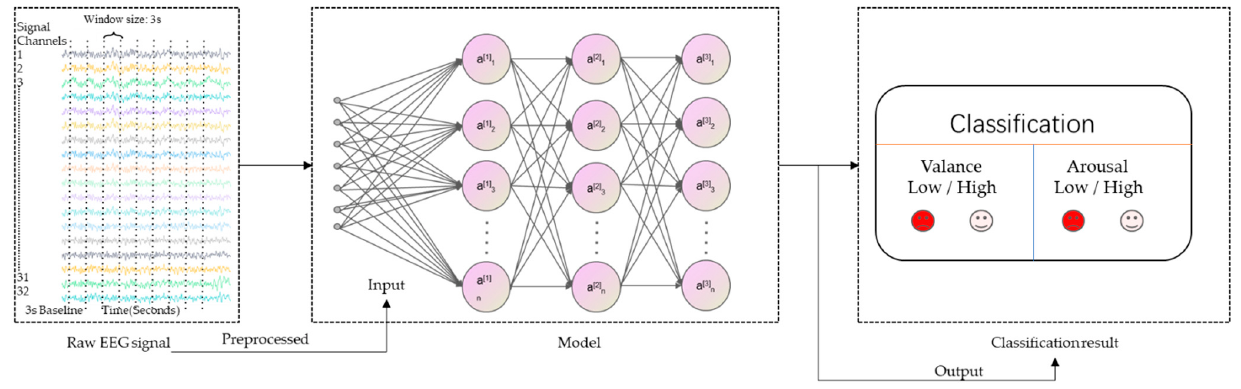
Figure 5. Process of emotion recognition using EEG.